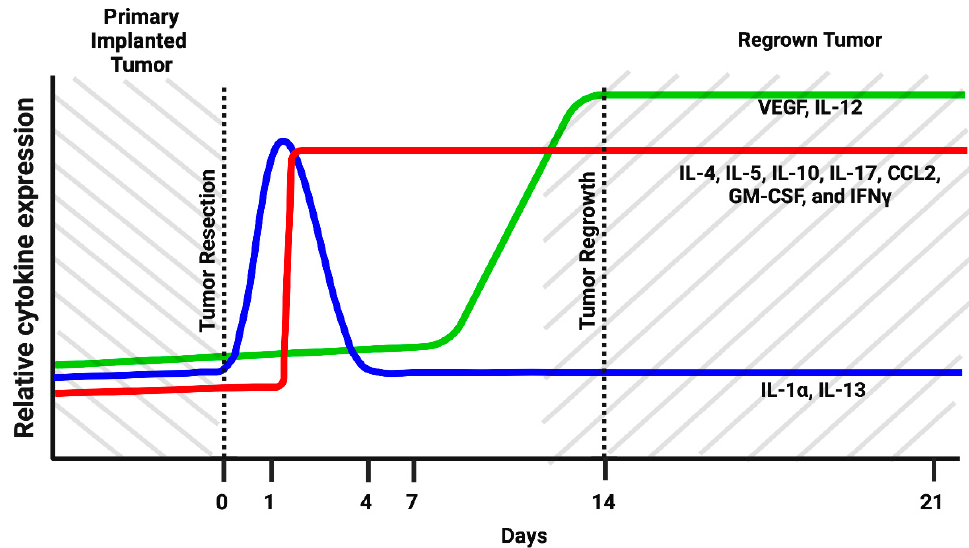
Figure 6. Schematic representation of the dynamic changes in myeloid cells cytokine expression pattern in tumor resection site during postsurgical period in the GL261-C57BL/6 mouse glioma implantation model. (Created with BioRender.com (accessed on 28 June 2022)) .